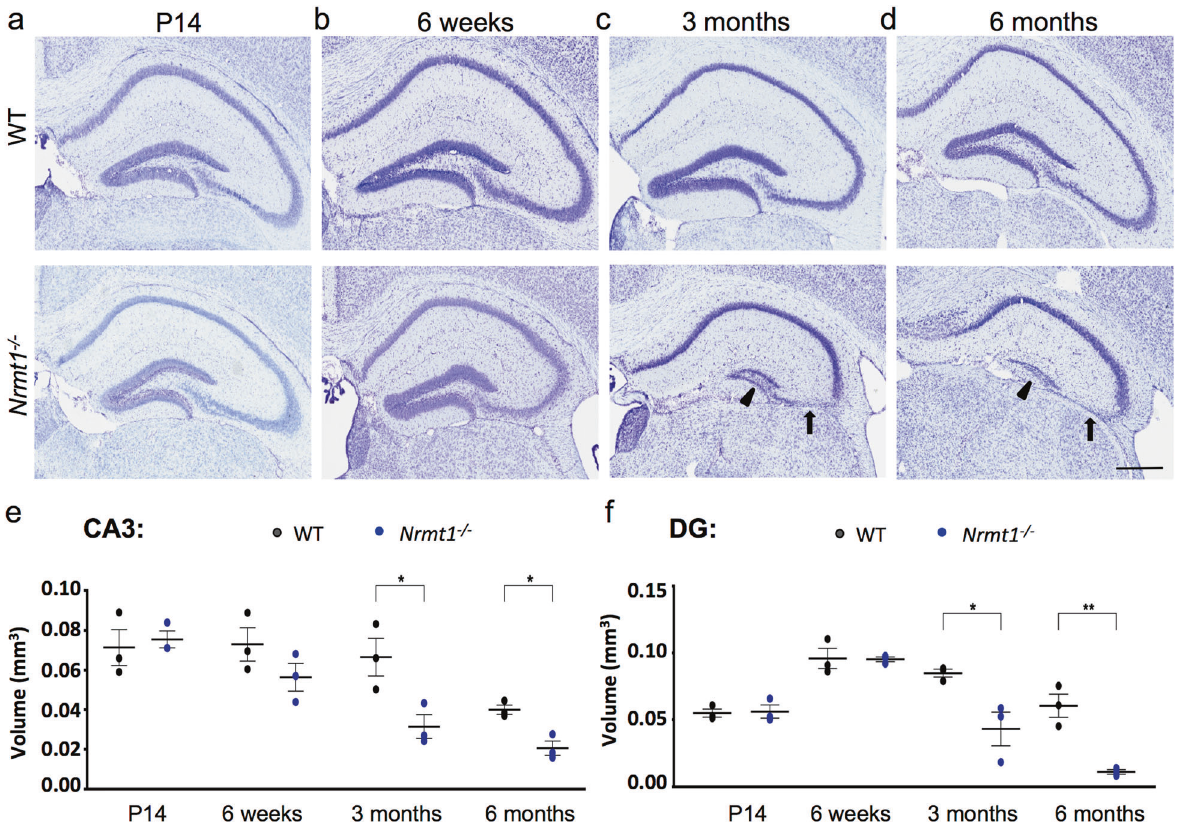
Fig. 2 Nrmt1 − / − mice show degeneration of hippocampal neurons. Cresyl violet staining of hippocampal neurons shows similar morphology between Nrmt1 − / − and WT mice at a P14 and b 6 weeks. However, at c 3 months, Nrmt1 − / − mice show degeneration of neurons in the CA3 (arrow) and DG (arrowhead). d By 6 months, neuronal staining is almost completely absent in the CA3 and DG. Quanti fi cation of e CA3 and f DG volume. * p < 0.05 and ** p < 0.005 as determined by unpaired t -test, n = 3. Error bars represent mean ± SEM. Scale bar = 400 μ